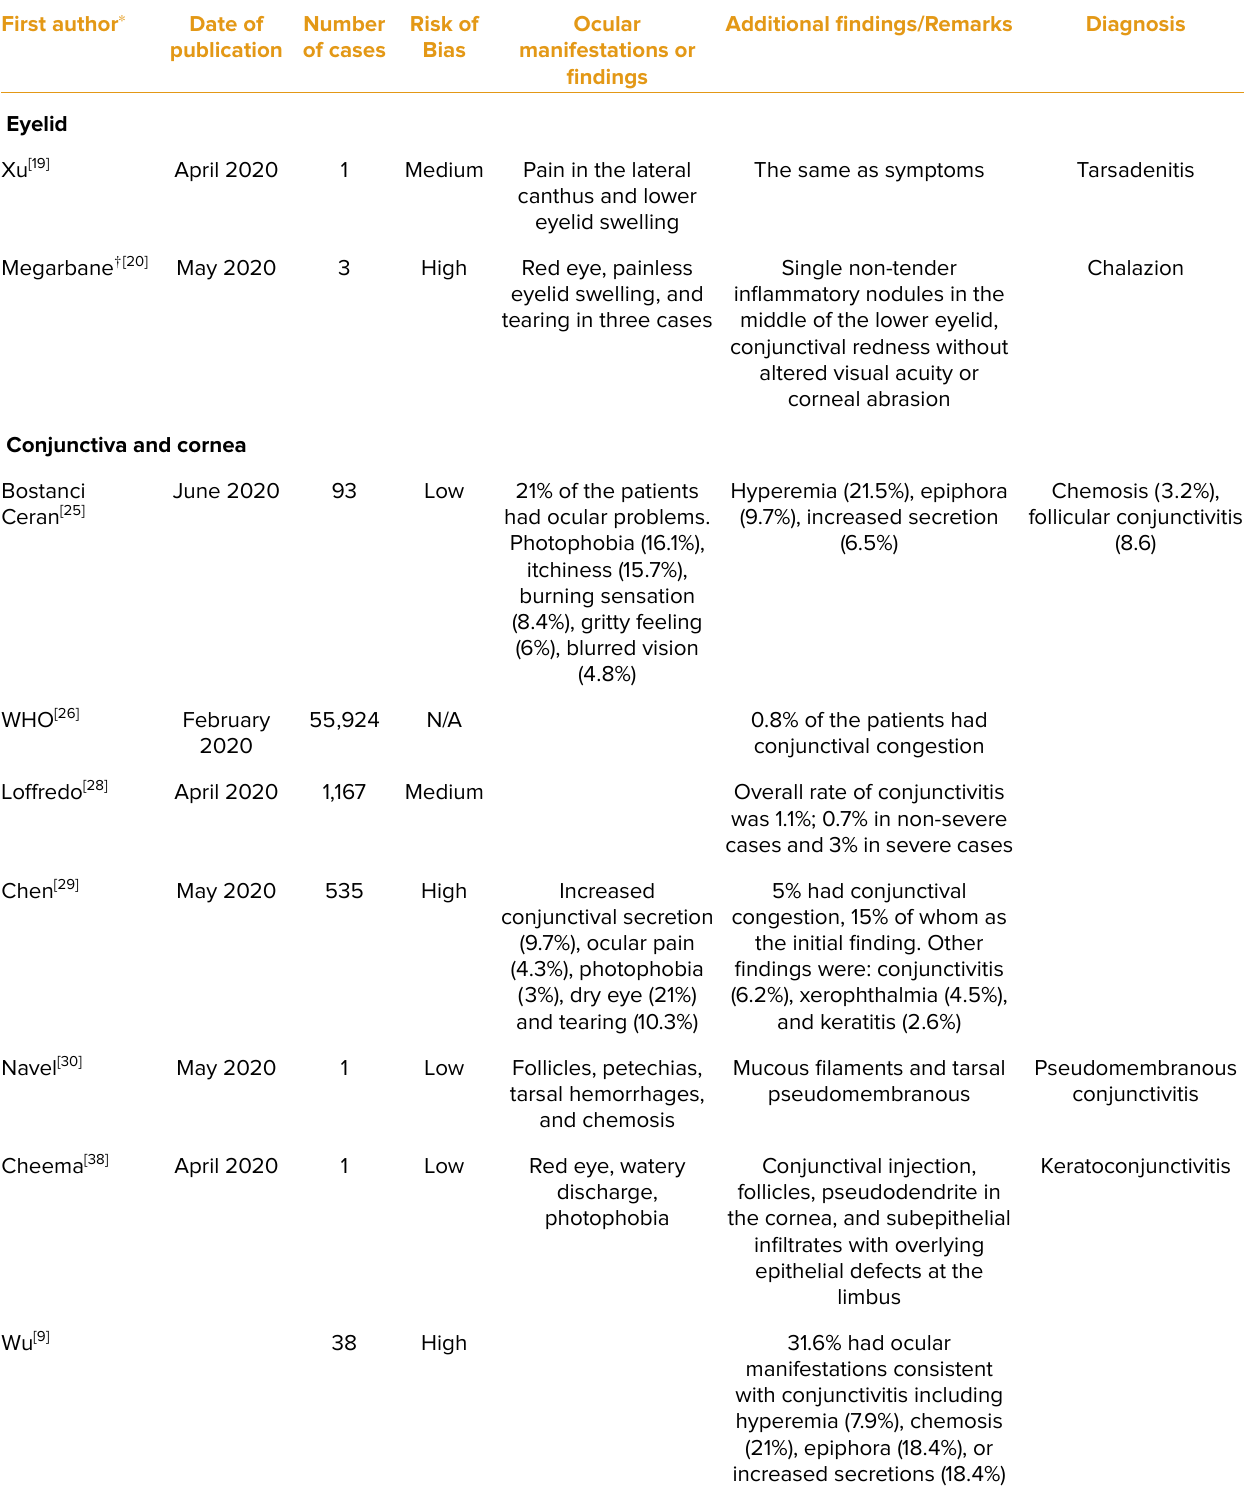
Table 1. Characteristics and main findings of the included studies (eyelid, ocular surface, episcleral, uveal, and ocular motor nerve